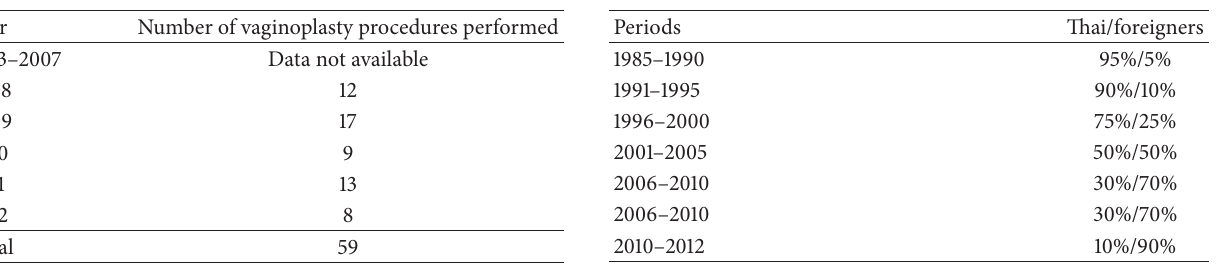
Table 1: Number of vaginoplasty procedures performed at Chula- longkorn University Hospital.